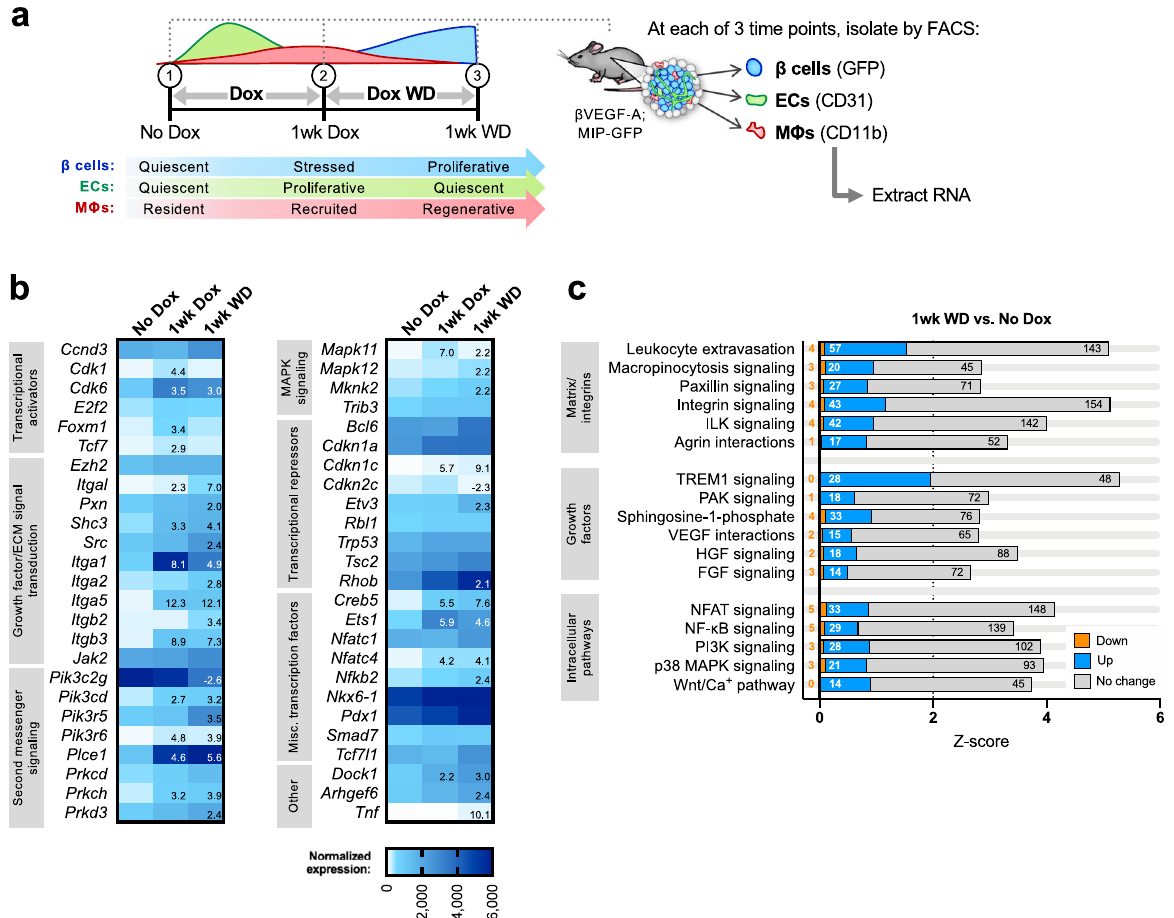
Fig. 5 Genes and pathways upregulated in β cells during recovery re fl ect activation of intracellular signaling to promote proliferation. a Experimental schematic showing sorting of islet-derived β cells, endothelial cells (ECs), and macrophages (M Φ s) from β VEGF-A mice